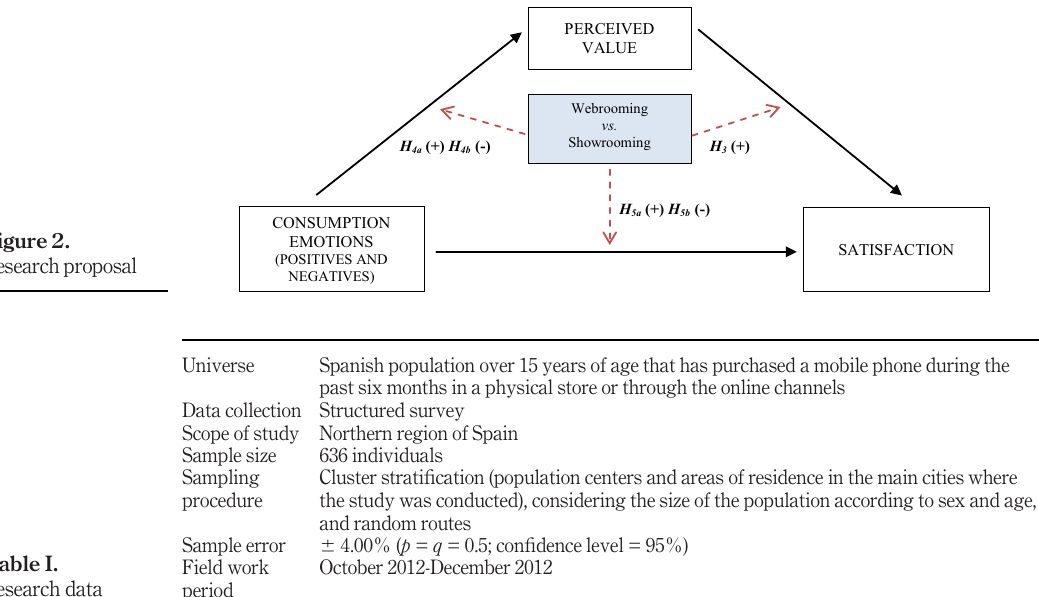
Table I. Research data